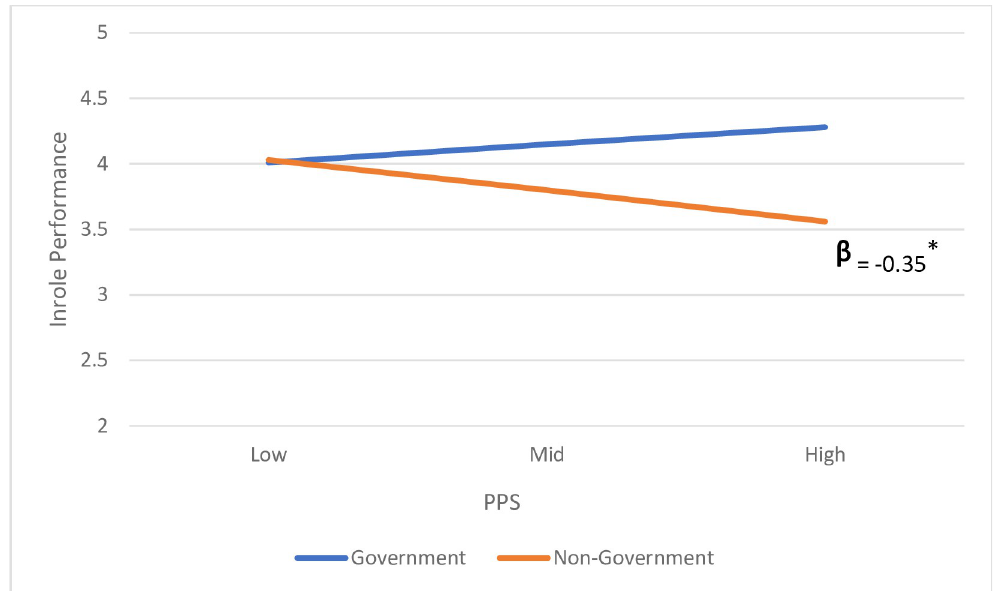
Fig 2. The relationship between perceived publicness and in-role